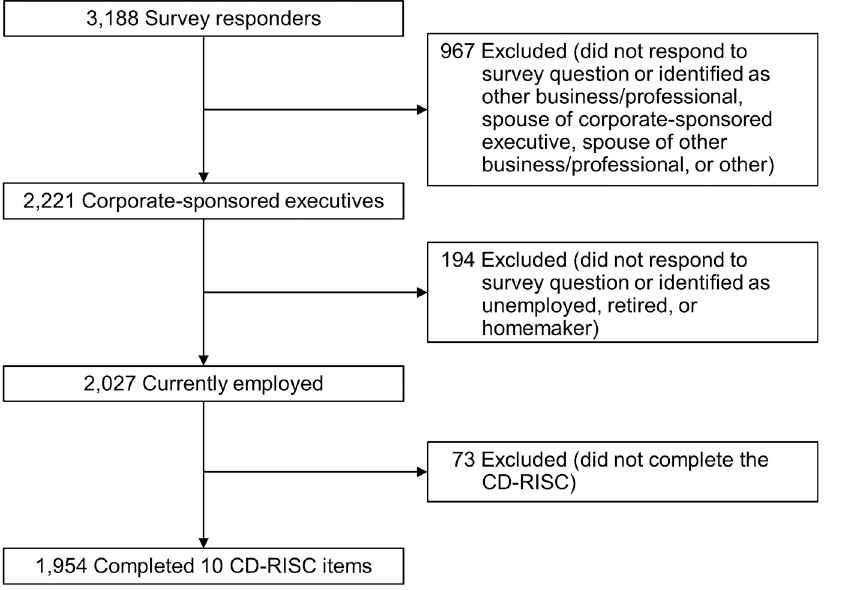
Fig 1. Flow diagram of patient selection. CD-RISC indicates Connor-Davidson Resilience Scale.